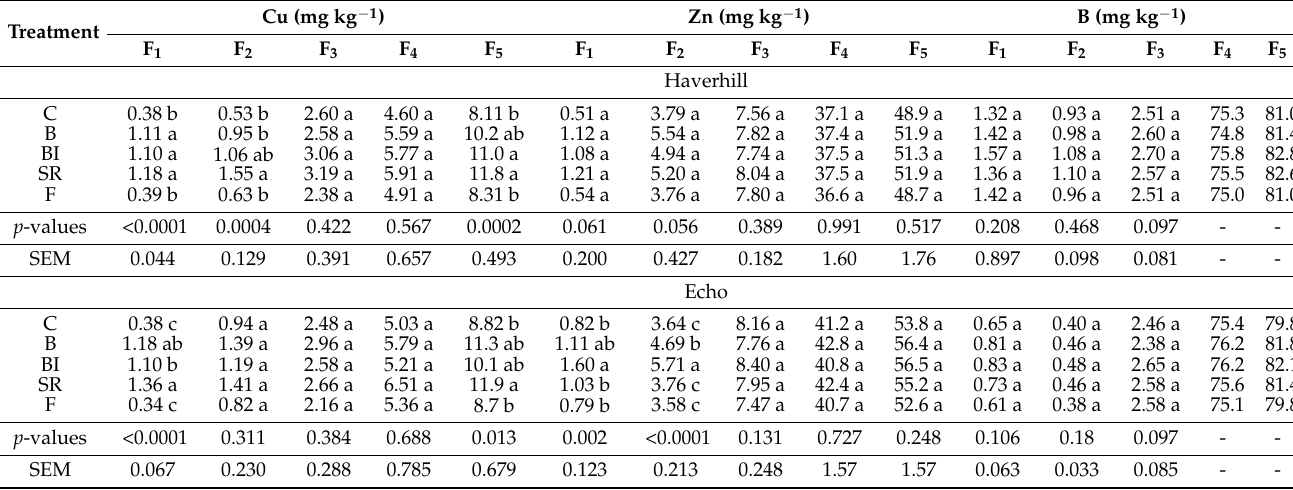
Different fractions of micronutrients are F 1 : soil solution-carbonate-exchangeable fraction (Cu and Zn) or specifi- cally adsorbed fraction (B); F 2 : oxyhydroxide fraction; F 3 : organic-bound fraction; F 4 : residual fraction; F 5 : total concentration in soil. Cu, Zn, and B fertilizer were applied for growing wheat, pea, and canola, respectively. Crops were grown at two sites in the field representing two different landscape elevation positions classified as Haverhill (upslope) and Echo (downslope) soil associations, respectively. Treatment evaluation includes C: control; B: broadcast; BI: broadcast and incorporation; SR: seed row banding; and F: foliar methods of fertilizer application. Means followed by the same letter in a column for treatments at a site are not statistically significant ( p > 0.05). SEM = Standard error of mean ( n =